Question: Summarize what this figure shows in one sentence.
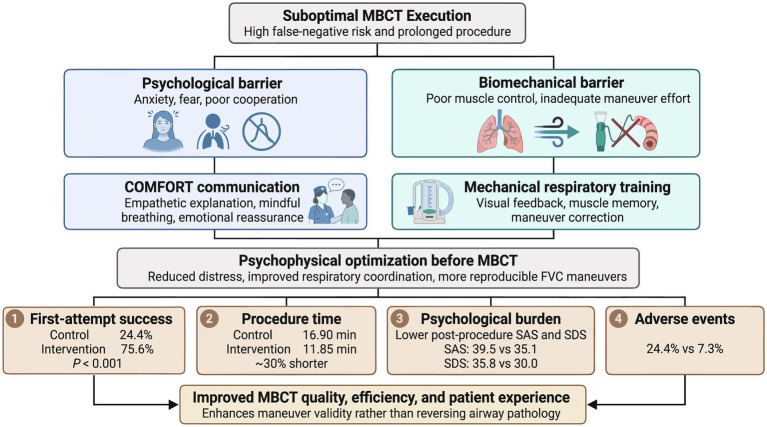
Answer: Mechanistic graphical abstract of COMFORT-based communication and respiratory training before MBCT. Psychological reassurance and respiratory maneuver rehearsal jointly reduce distress and correct suboptimal breathing mechanics before methacholine bronchial challenge testing. These effects improve first-attempt maneuver success, shorten testing time, and reduce mild procedure-related adverse events, while the observed spirometric gains reflect improved effort and maneuver quality rather than immediate physiological reversal of airway dysfunction.